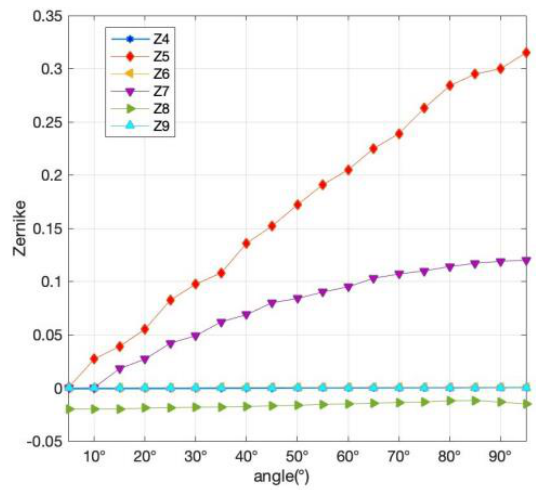
Figure 12. Z4–Z9 change curves in the gravity field.